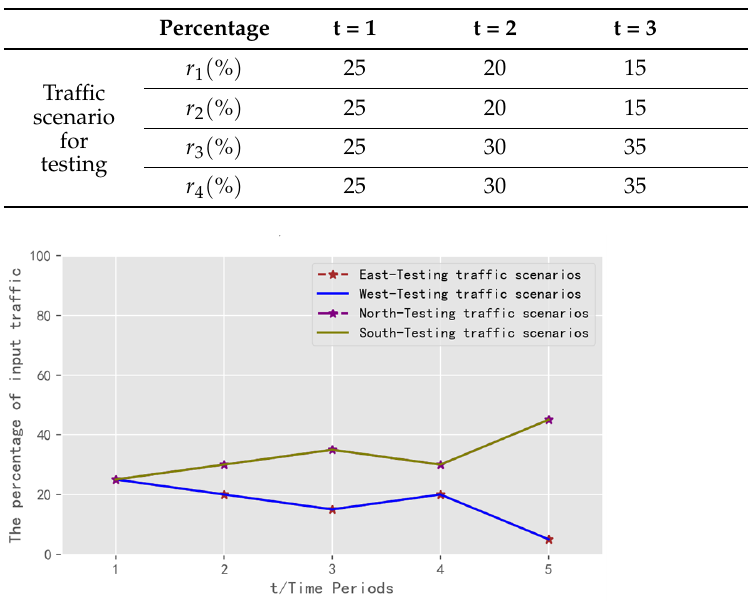
Figure 12. Diagram of traffic scenario 1 for testing: allocation of vehicles in each